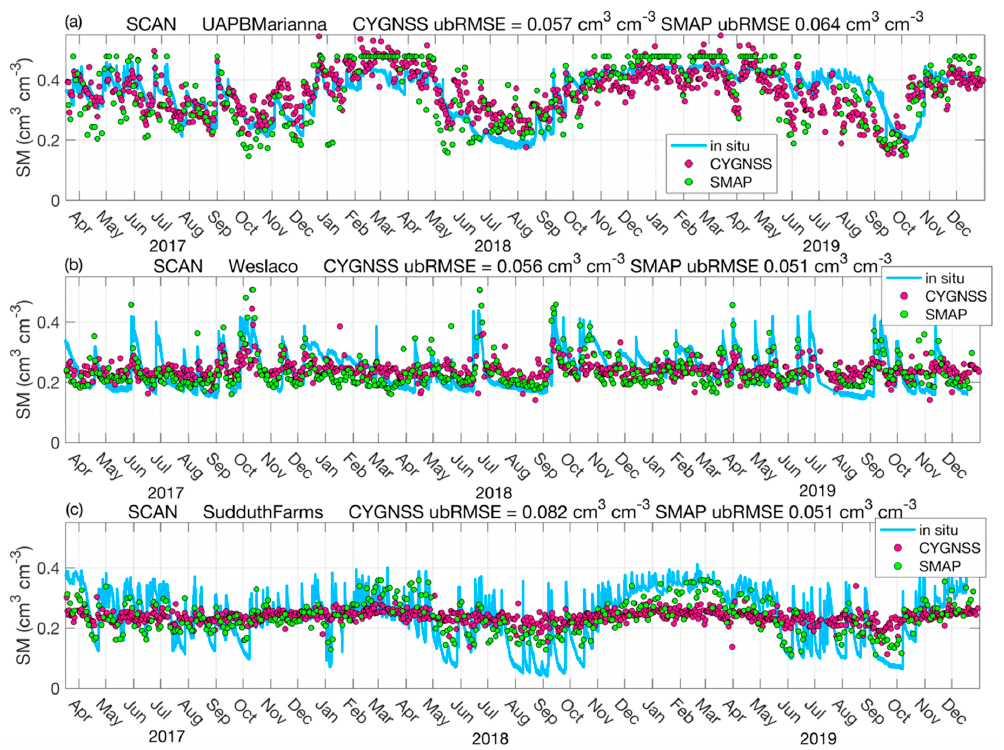
Figure 14. Examples of CYGNSS soil moisture retrievals that do not agree as well with in-situ probe measurements from SCAN UAPB Marianna ( a ), SCAN Weslaco ( b ), and SCAN SudduthFarms ( c ). SMAP data for these locations are shown for reference. The values of ubRMSE shown for each station is for the validation time period only (2 October 2018–31 December 2019).